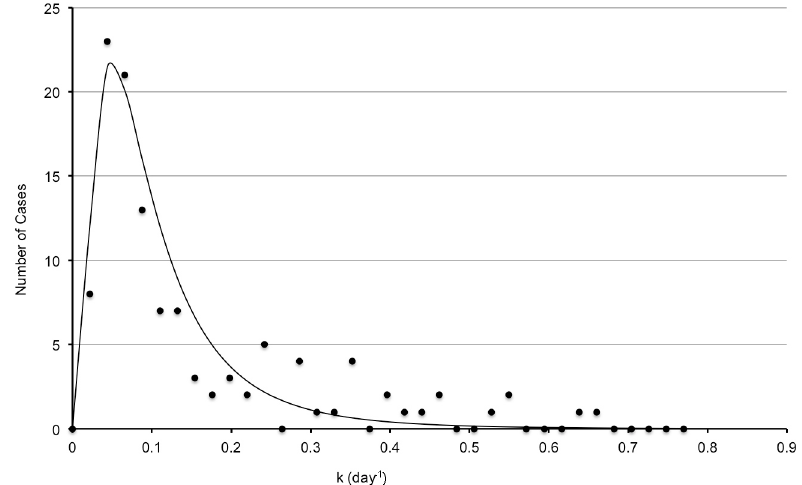
Fig 6. Malignant nodule growth rate distribution. Distribution of k -values for 120 malignant nodules as determined by Veronesi[9]. The dashed line represents the best fit lognormal distribution with mean ln(0.015) and standard deviation